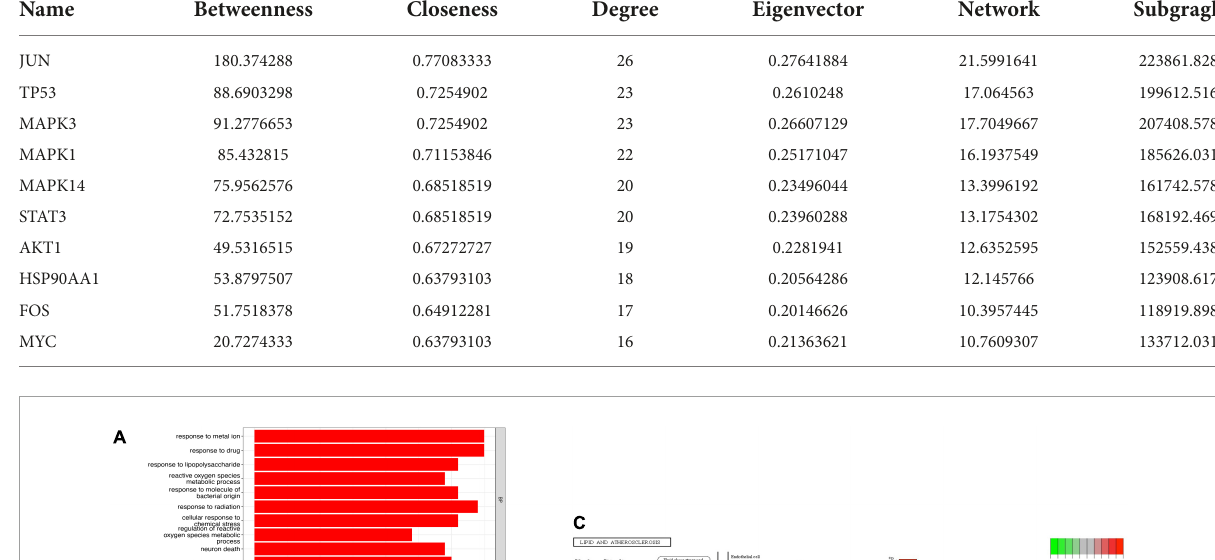
TABLE 3 Topological parameters of the top 10 core targets.